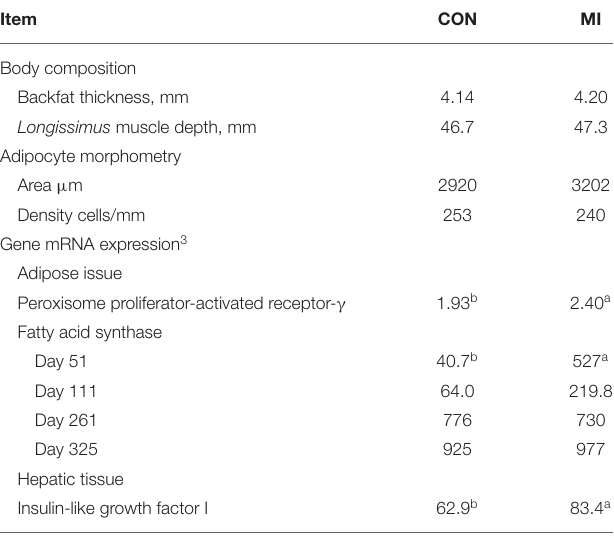
TABLE 3 | Body composition and mRNA expression of genes associated with lipogenesis and growth in beef heifers receiving (MI) or not (CON) a corn-based supplement ad libitum from 2 to 4 months of age via creep feeding 1,2